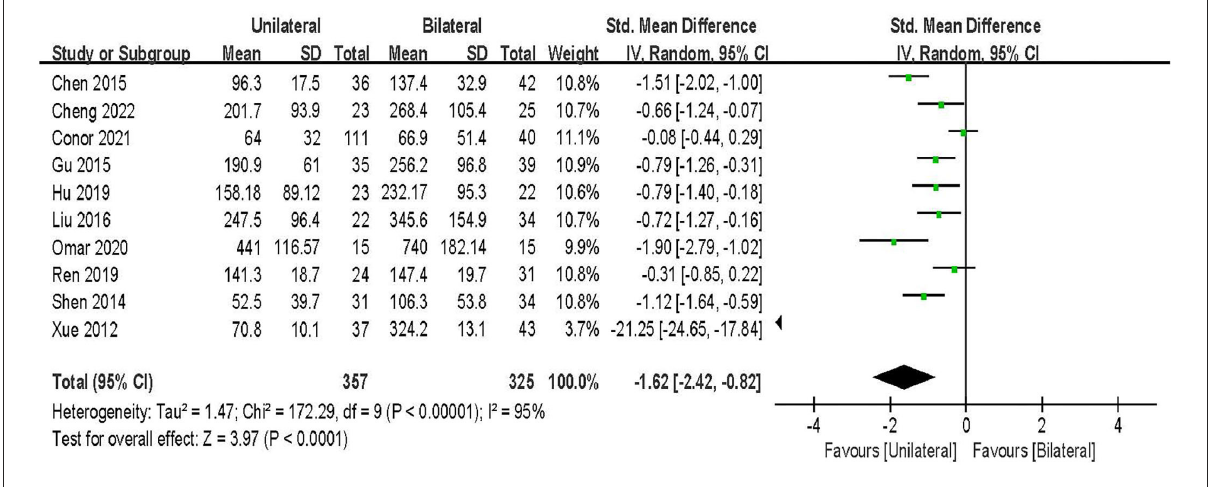
FIGURE8 Forest plot of blood loss.